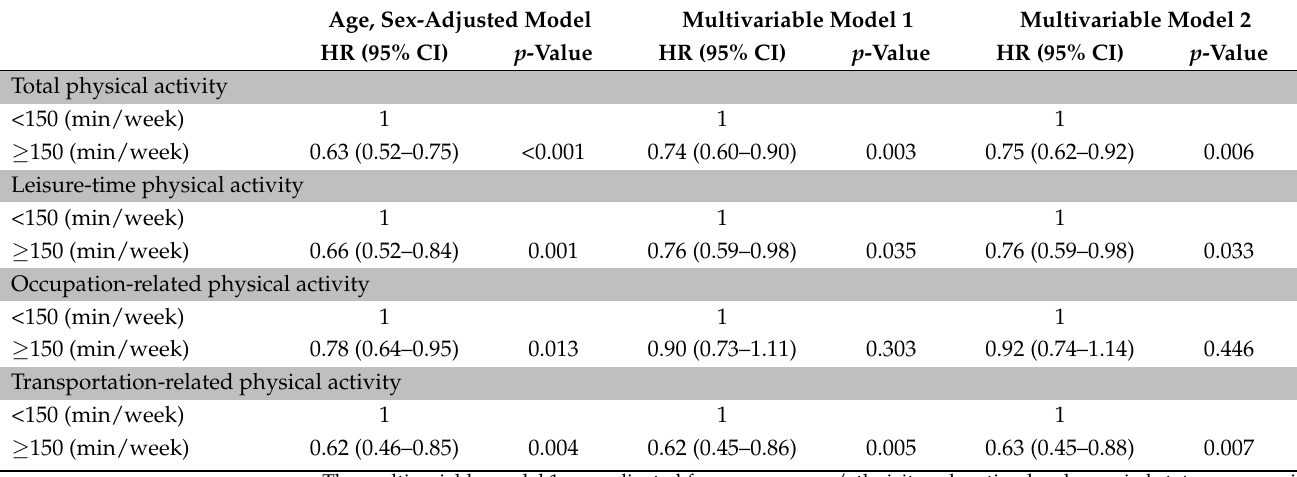
Table 2. Multivariable Hazard Ratio for All-Cause Mortality based on the Meeting Physical Activity Guidelines among Individuals with NAFLD as defined by the Hepatic Steatosis